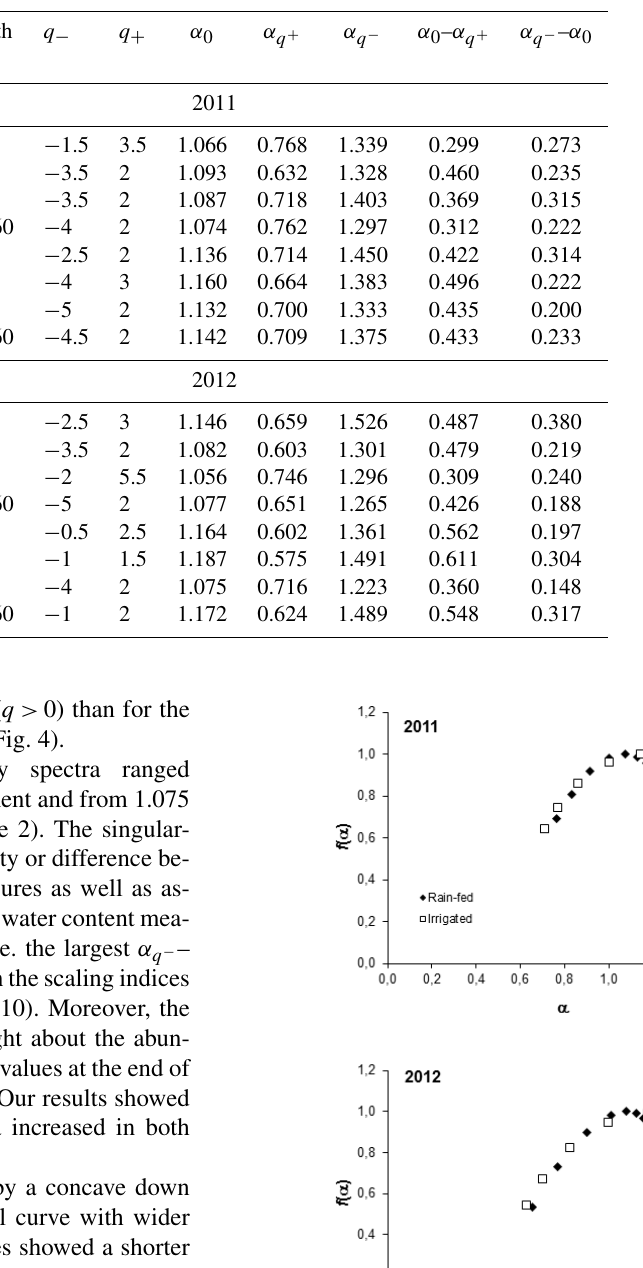
Table 2. Selected multifractal parameters derived from the f (α) singularity spectra: most positive ( q + ) and most negative ( q − ) limits the range of multifractal scaling, Hölder exponent of order 0 ( α 0 ), most positive ( α q + ) and most negative ( α q − ) exponents, widths of the left ( α 0 – α q + ) and the right ( α q − – α 0 ) sides of the spectra.